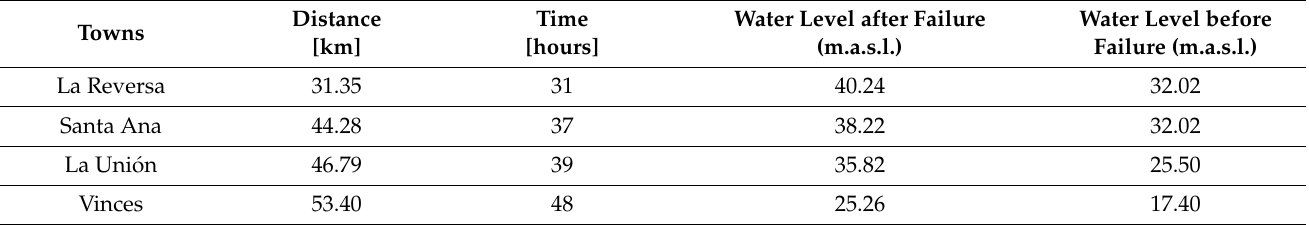
Table 12. Towns were affected by flood propagation after the dam failure.